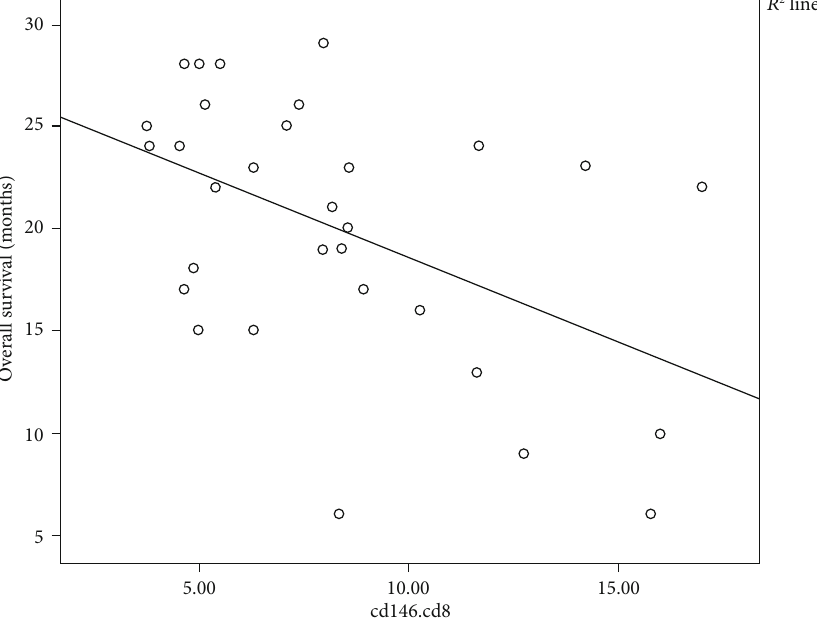
Figure 4: Scatter plot of the relation between CD146 + CD8 + cells and OS of 31 children with B-cell